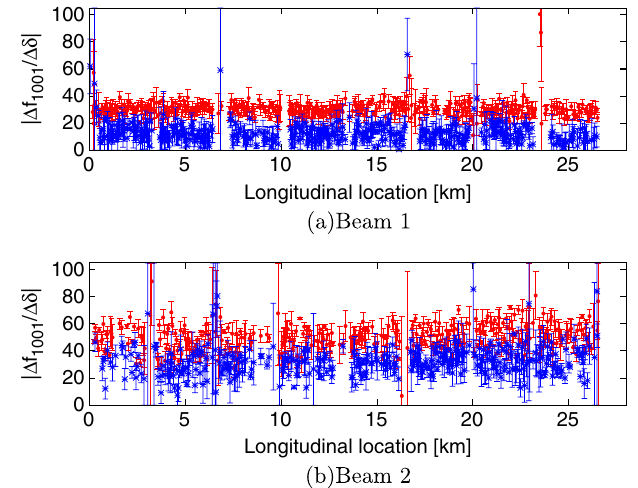
FIG. 7. The absolute value of the chromatic coupling before (red) and after (blue) correction.